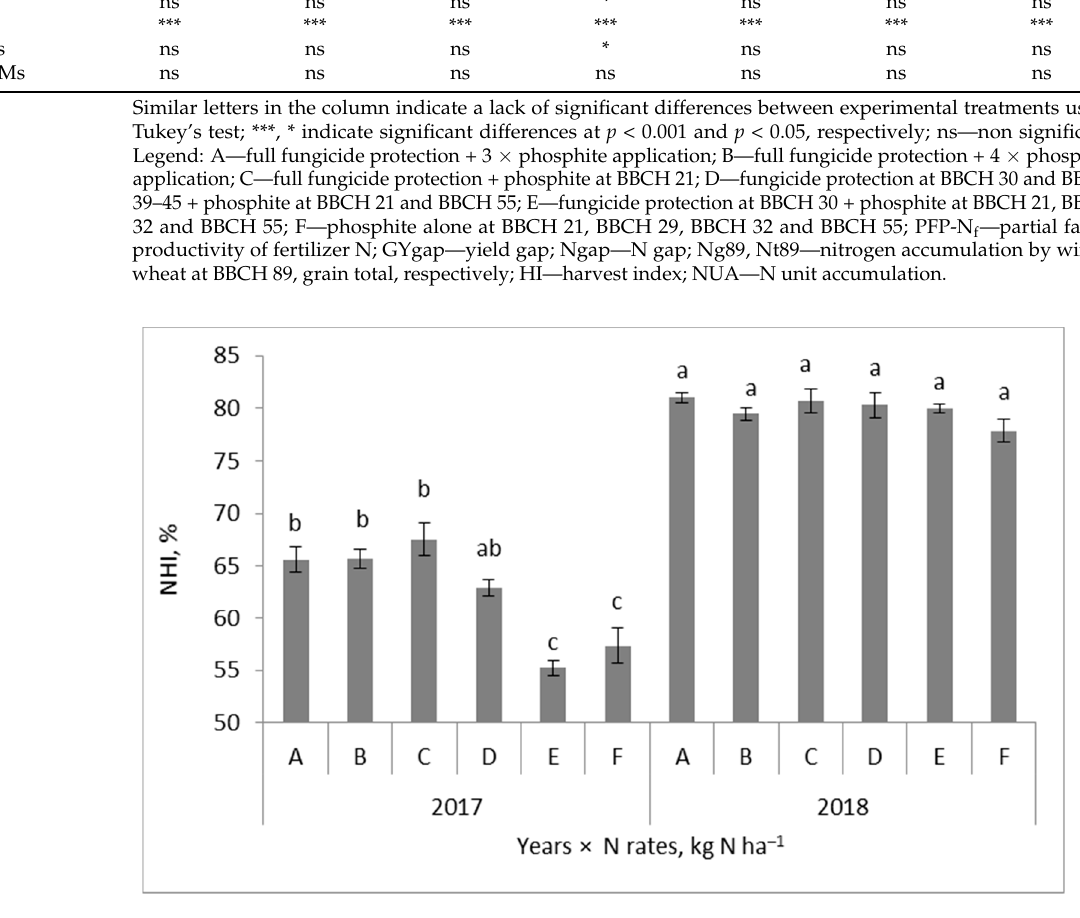
Figure 7. Effect of plant protection methods on nitrogen harvest index of winter wheat. Similar letters indicate a lack of significant differences between experimental treatments using Tukey’s test. The vertical bar in the column is the standard error of the